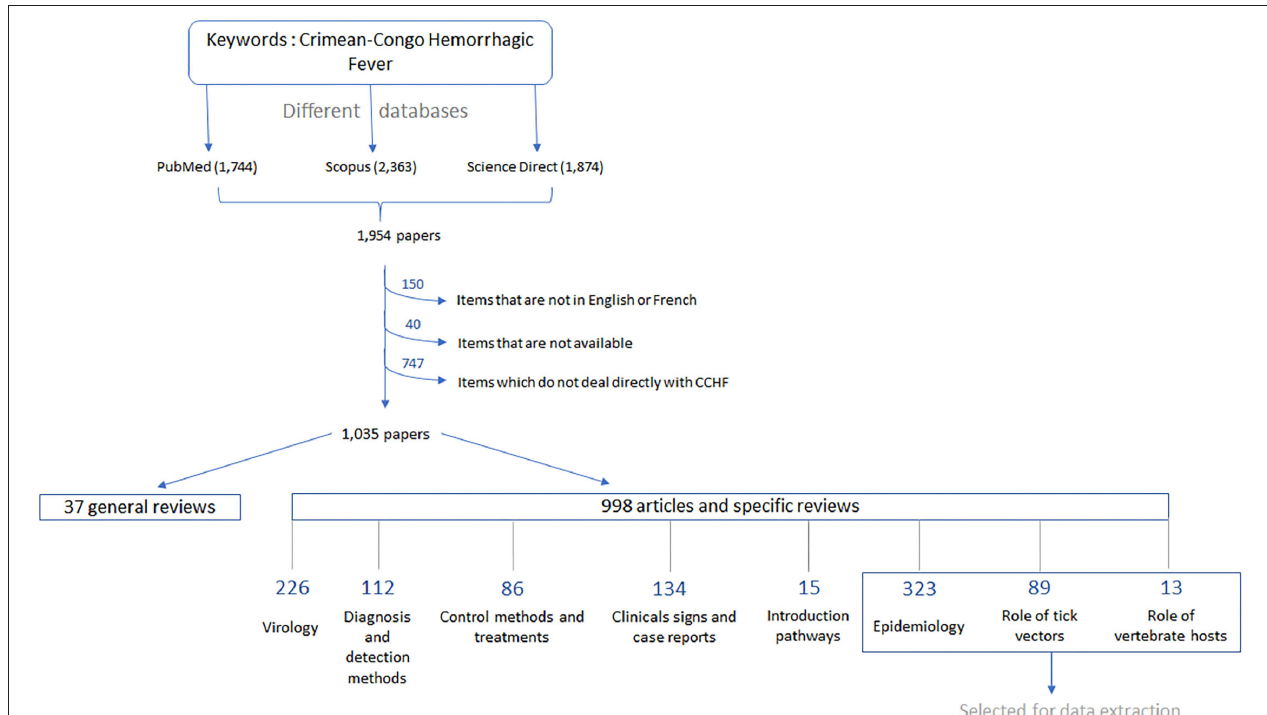
FIGURE 1 | Workflow summarizing the steps taken to classify the different articles in the literature and to select the categories of interest for our